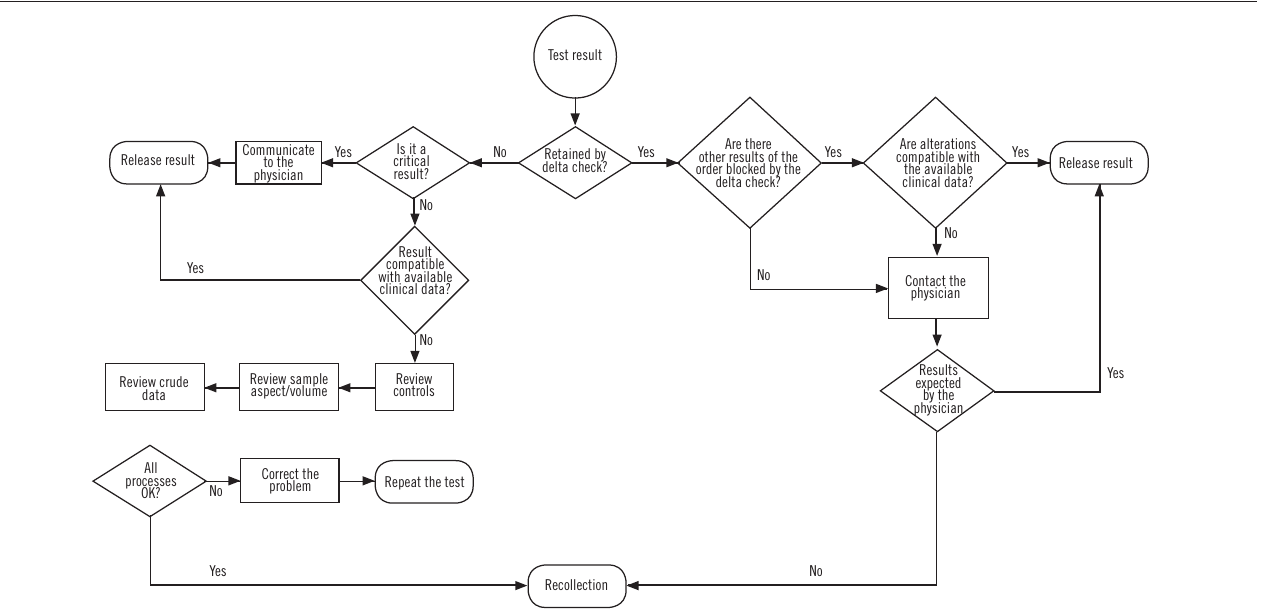
figurE 3 − Manual release flowchart of tests retained by autoverification at the core laboratory of HC/UFMG HC/UFMG: Hospital das Clínicas da Universidade Federal de Minas